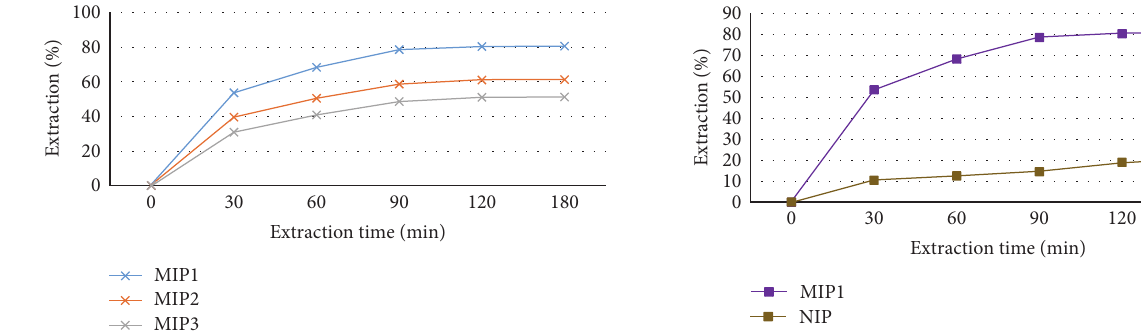
Figure 4: Cinnamic acid extraction efficiency depending on the extraction time among MIPs.